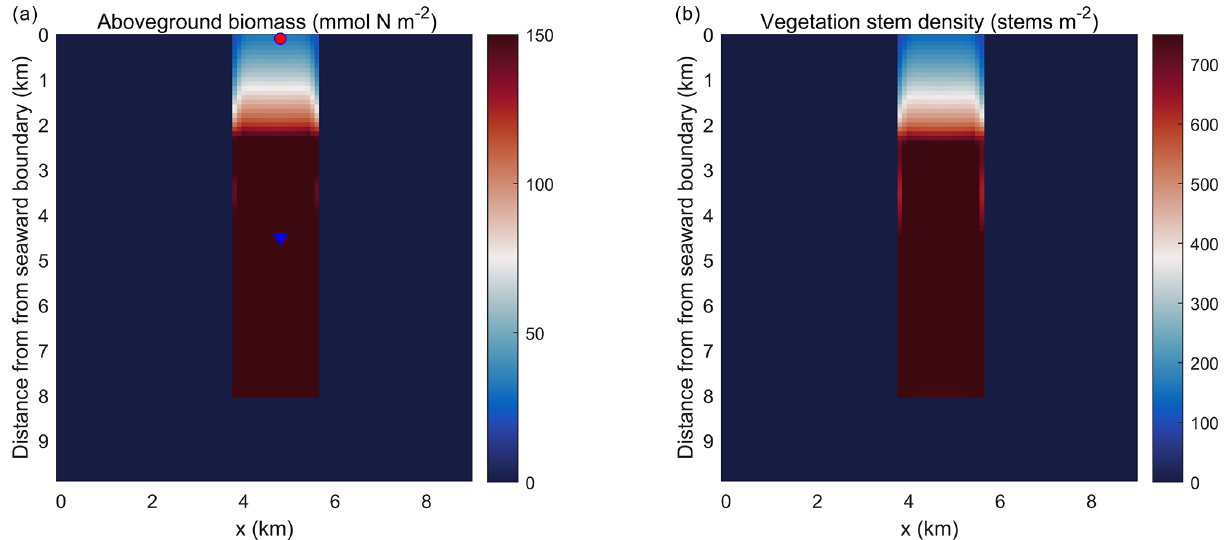
Figure 5. Planform view of (a) aboveground biomass and (b) vegetation stem density averaged over the last day of the simulation in the idealized domain. The red dot and blue triangle represent two points that are located at 0.1 and 4.5km into the SAV bed,